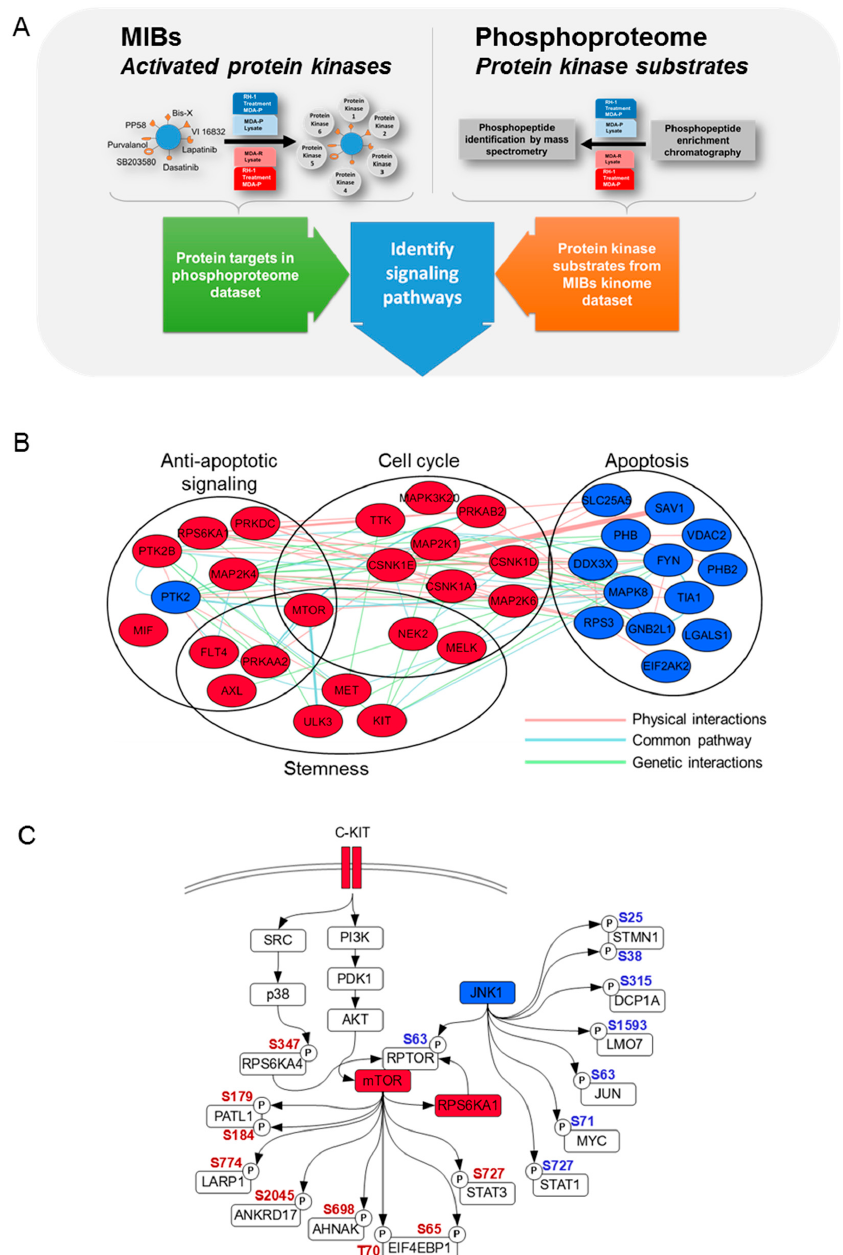
Figure 3. Protein phosphorylation highlights signaling pathways in RH1-resistant cells. ( A ). Experimental workflow for kinome and phosphoproteome analysis. ( B ). MIB analysis of increased and decreased kinase activity between MDA-P and MDA-R cells. MDA-P and MDA-R cells were subjected to MIB analysis, followed by quantitative proteomic analysis. Kinase di ff erential activity, interaction and functional annotation network was built by means of Cytoscape software with GeneMANIA application. The main functional clusters are represented and the color of the nodes demonstrates kinase activity change (red—increased, blue—decreased). ( C ). JNK1 and c-KIT-AKT-mTOR signaling pathways. Most biologically important pathways were analyzed combining MIB and phosphoproteome datasets. Red node color indicates increased activity of MIB dataset kinases, blue—decreased. Red phosphosite color indicates increased phosphorylation in the phosphoproteome dataset, blue—decreased. AKT and JNK phosphosites were identified by Western blot. Nodes without color indicate proteins that belong to the pathway but have neither been identified nor their phosphorylation changes were observed in either of